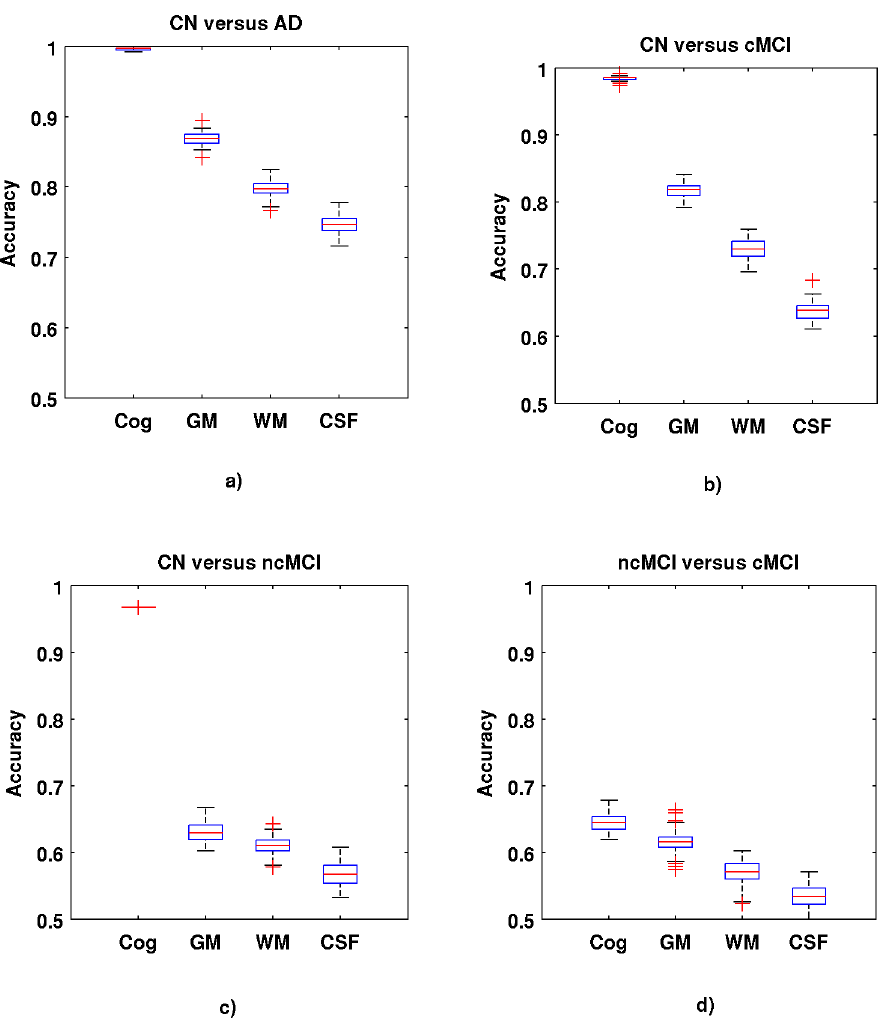
Figure 3. The GM, WM and CSF discriminative maps produced by logistic regression with sparsity regularization are overlaid on the study customized template generated by DARTEL. In each case, nine coronal slices ( 2 82, 2 68, 2 52, 2 38, 2 22, 2 8, 8, 22, 38) are shown (neurological convention) in the first, second, and third rows, respectively. The blue areas are associated with AD classification, while the red ones are associated with CN